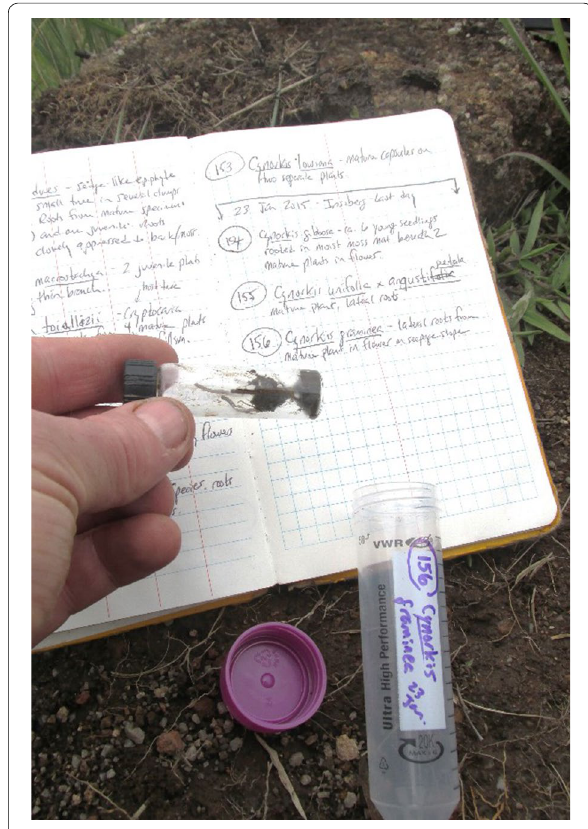
Fig. 5 (Right) A pre-sterilized glass sampling vial containing root seg- ments of a terrestrial orchid. The screw cap lid remained untightened to permit gas exchange leading up to air transport out of Madagas- car. Each glass vial was placed into a plastic, shatterproof centrifuge vial during transport from Madagascar to the